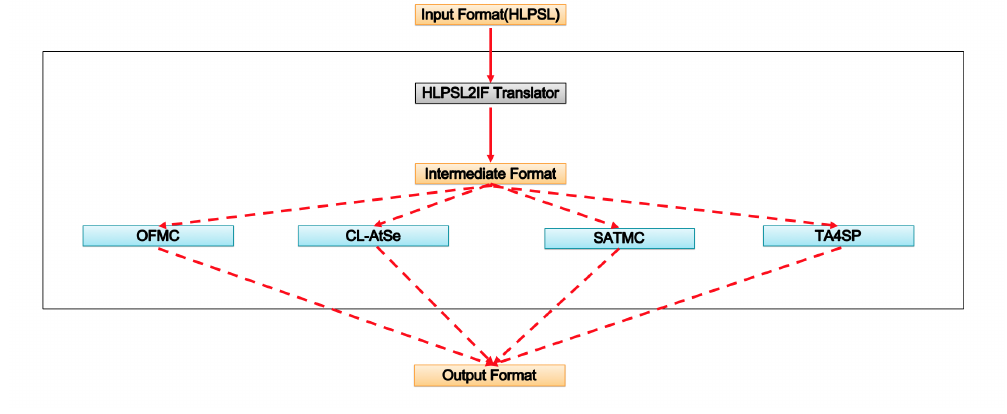
Figure 5. Architecture of the AVISPA tool